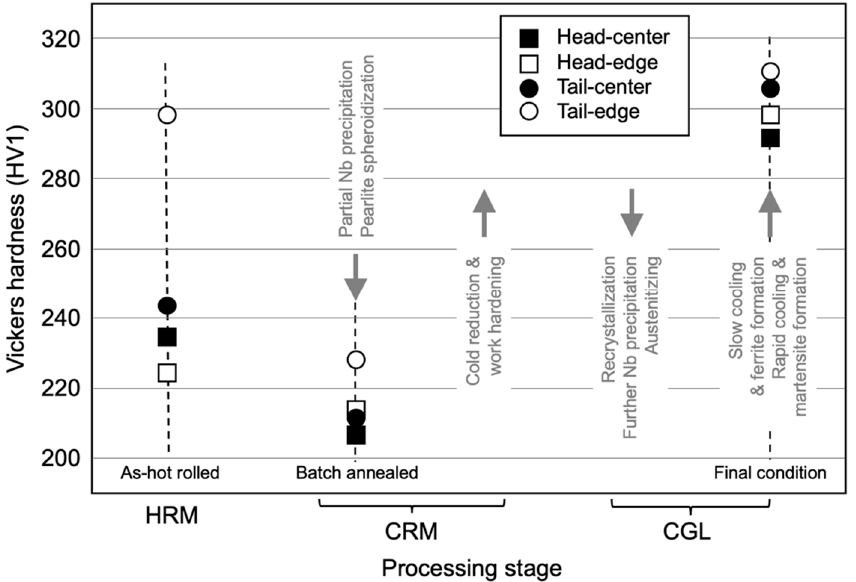
Figure 3. Hardness measurements (HV1) at various coil positions and treatment stages in the hot rolling mill (HRM), cold rolling mill (CRM) and continuous galvanizing line (CGL); hardness-relevant metallurgical influences of intermediate processes are indicated by arrows.